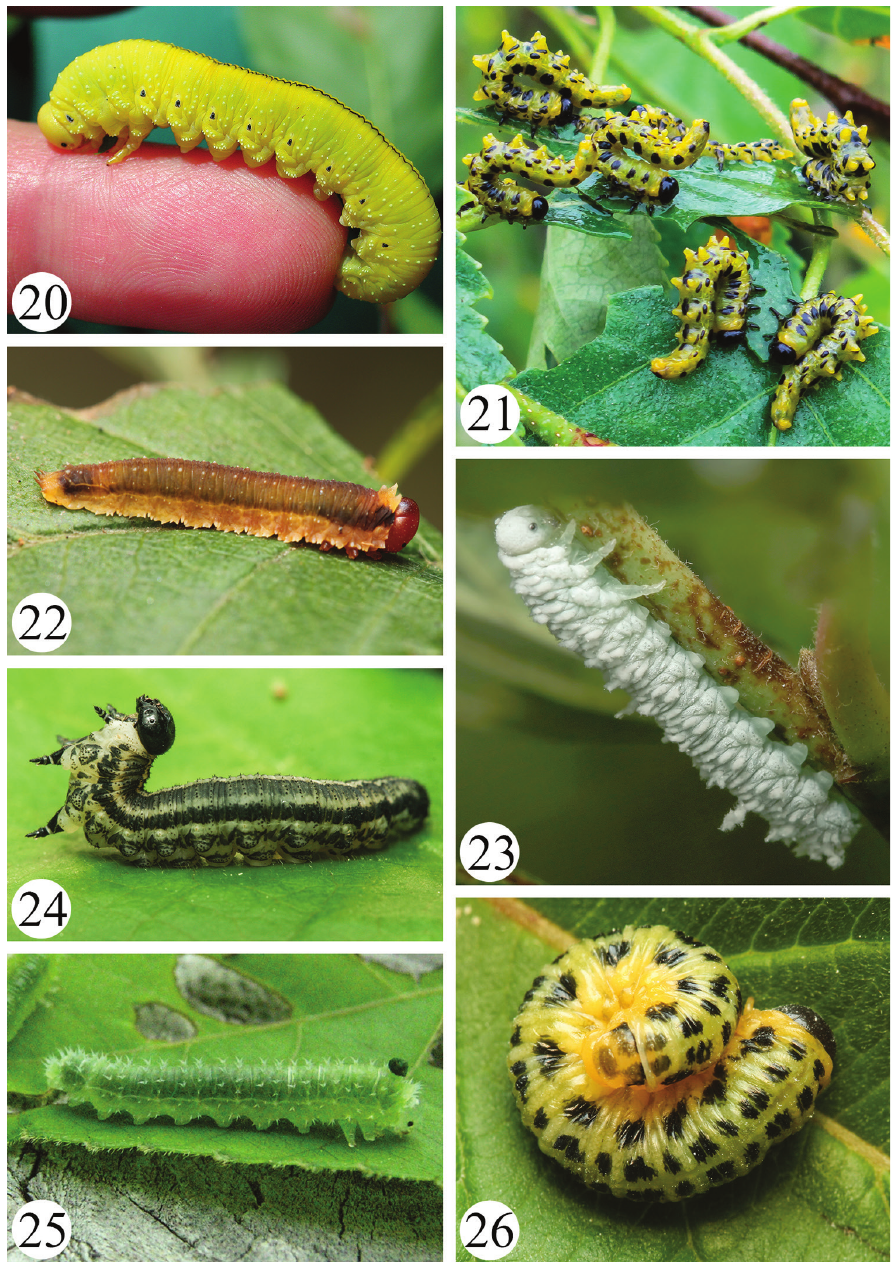
Figures 20–26. Sawfly larvae 20 Cimbex americanus (Cimbicidae) Lake Manitou, ON, Canada 21 Nematus (= Craesus ) latitarsus (Tenthredinidae: Nematinae), Vancouver, BC, Canada 22 Dimorphop- teryx sp. (Tenthredinidae: Allantinae) Driftwood Prov. Park, ON, Canada 23 Eriocampa ovata (Tenthredi- nidae: Allantinae) St. Andrew’s, NF, Canada 24 Neodiprion nanulus (Diprionidae) Ottawa, ON, Canada 25 Eupareophora parca (Tenthredinidae: Blennocampinae) Ottawa, ON, Canada 26 Macremphytus testa- ceus (Tenthredinidae: Allantinae) Ottawa, ON,